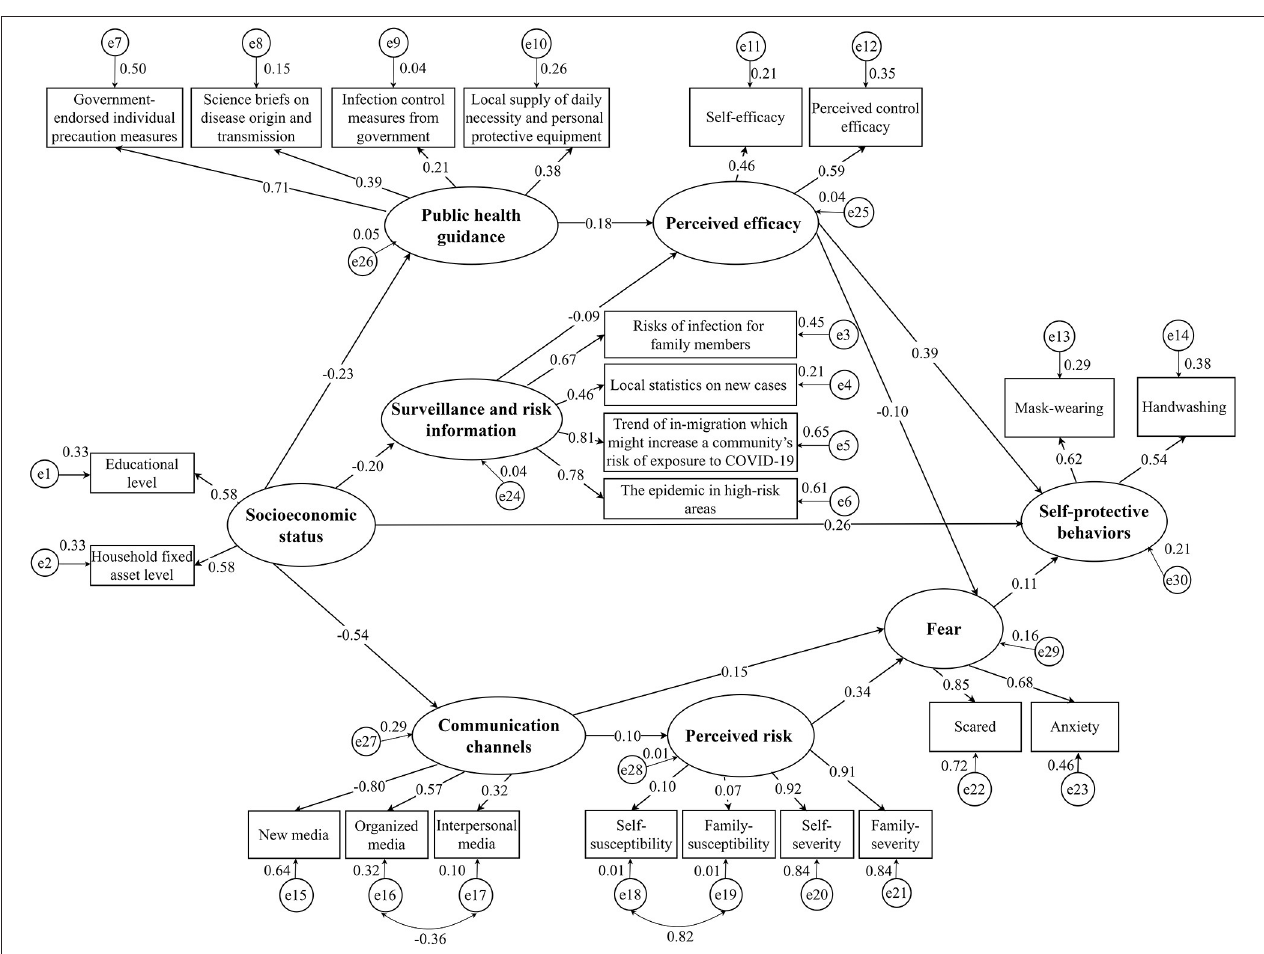
FIGURE 2 | Structural equation modeling examining pathways to self-protective behaviors in response to COVID-19 among women in rural western China ( N = 1,524). The final adjusted model had a better fit than the basic model with the following indicators: NFI = 0.85, GFI = 0.94, CFI = 0.87, RMSEA = 0.06, and χ 2 /df = 5.88. Coefficients are standardized path coefficients. Variables in ellipse represent latent variables, in squares represent observed variables. Self-efficacy indicates the confidence one’s to solve problems when preventing COVID-19. Perceived control efficacy indicates the confidence to protect oneself from getting infected COVID-19. Self-susceptibility indicates the probability of one’s being infected with COVID-19. Family-susceptibility indicates the probability of one’s family being infected with COVID-19. Self-severity indicates COVID-19 is a serious disease to oneself. Family severity indicates COVID-19 is a serious disease to one’s family. Scared indicates COVID-19 makes oneself scared. Anxiety indicates COVID-19 makes oneself anxious. NFI, normed fit index; GFI, goodness-of-fit index; CFI, comparative fit index; RMSEA, root mean square error of approximation. (Data source: Authors’ study).